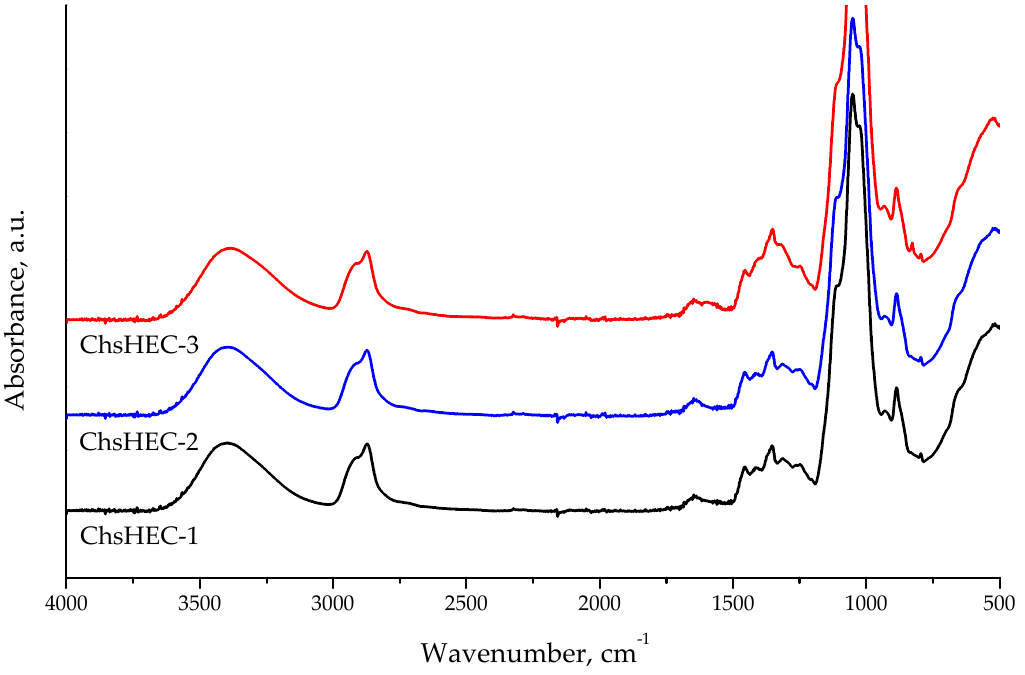
Figure 1. IR-spectra of water-soluble (at neutral pH) fractions of the ChsHEC samples.